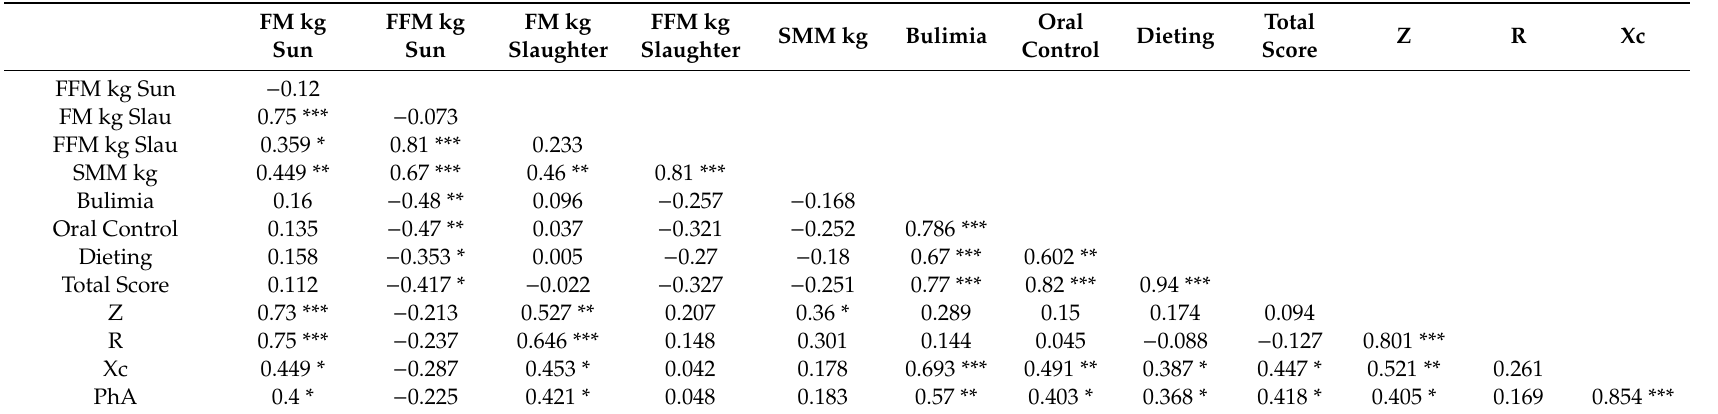
Table 2. Spearman’s rank correlation coe ffi cients between body composition and BIA variables with subscales EAT-26 in Basic Teachings.